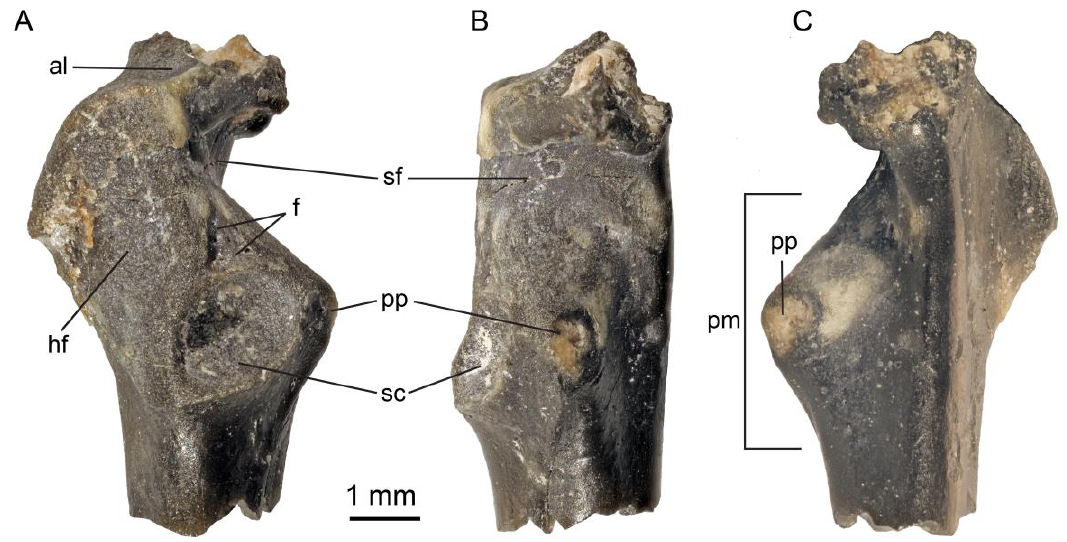
Figure 3. The coracoid of the Uintan paraortygid (UMNH.VP.30891) from the Eocene Uinta Formation. Coracoid in ( A ) dorsal; ( B ) medial; and ( C ) ventral views. Abbreviations: al—scar for the acrocoracohumeralis ligament; f—fossa; hf—humeral articular facet; pm—procoracoid prominence; pp—procoracoid process; sc—scapular cotyle; sf—m. supracoracoideus fossa.